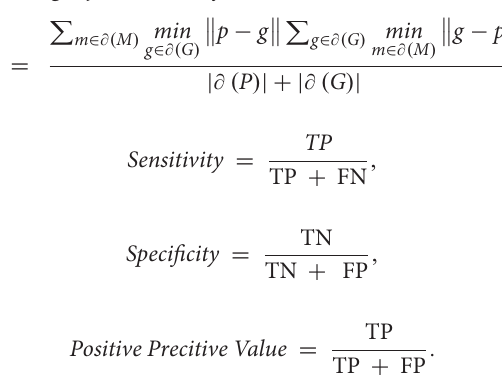
Frontiers in Aging Neuroscience |